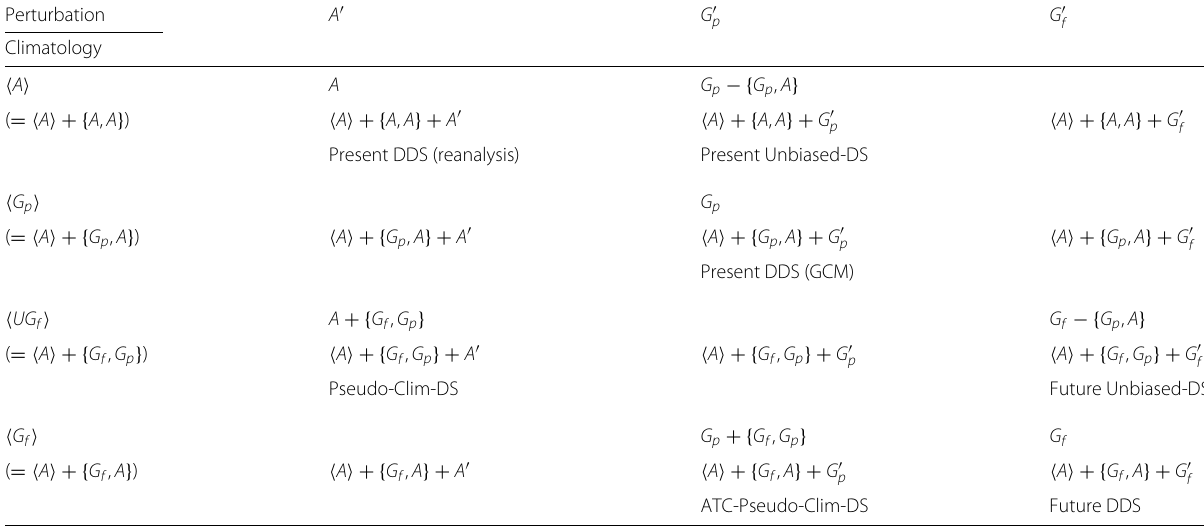
Table 1 Possible large-scale states driving downscaling with reanalysis and GCM simulations in present and future climates Perturbation